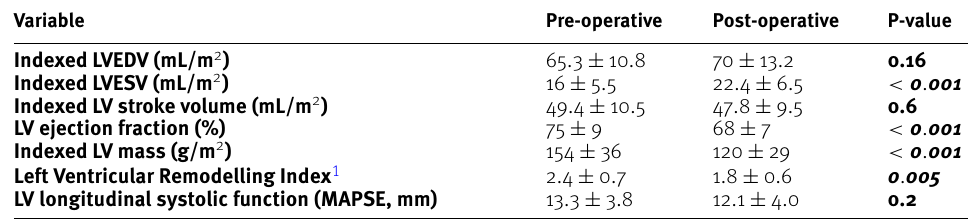
Table 4. Changes in global LV function following tailored myectomy for